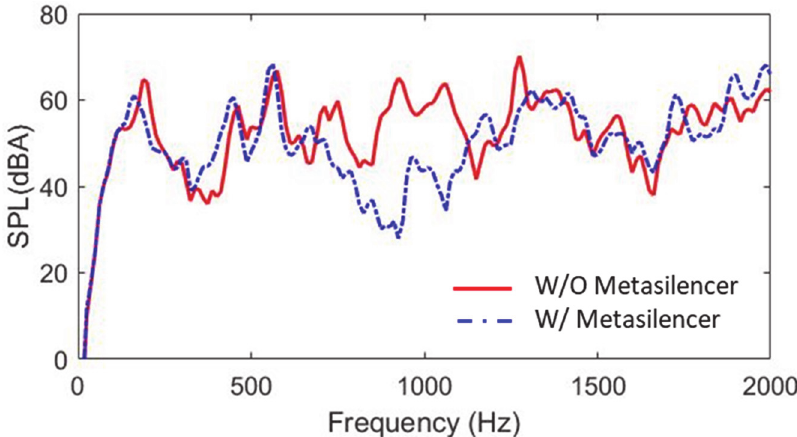
Figure 13. Speaker test result of the metasilencer.